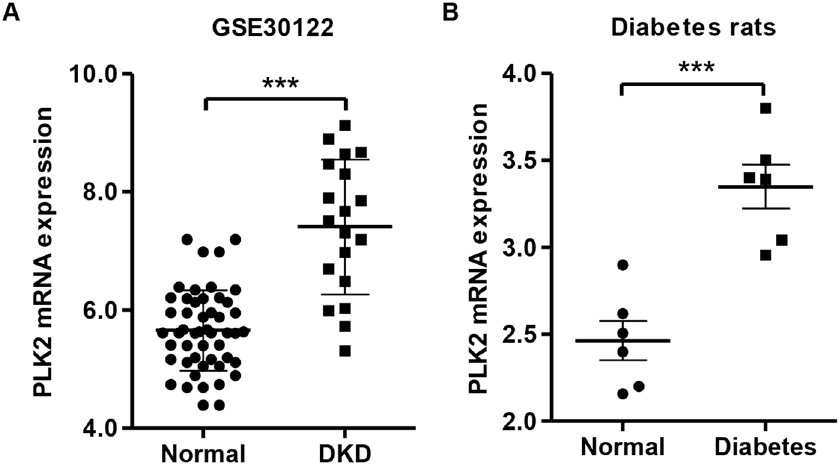
Figure 1. PLK2 up-regulation in DKD patients and diabetic rat models. ( A ) PLK2 expression in glomeruli and tubuli from DKD patients, gene data were from National Center for Biotechnology Information Gene Expression Omnibus (GSE30122). ( B ) Expression of PLK2 in glomeruli was significantly increased in diabetic rats. *** P <